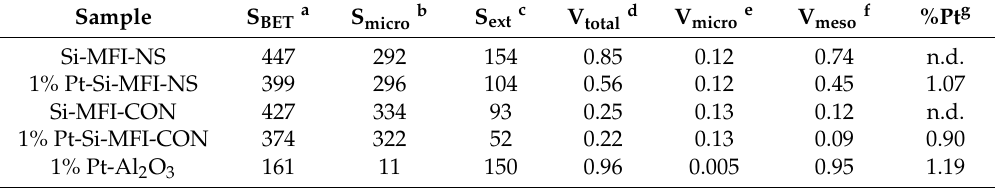
Figure 1. Characterizations of various Pt supported catalysts: ( A ) XRD patterns, ( B - D ) SEM images of Pt supported on hierarchical silicalite- 1 nanosheets (1% Pt-Si-MFI-NS), conventional silicalite- 1 (1% Pt-Si-MFI-CON) and alumina (1% Pt-Al 2 O 3 ), respectively, ( E – G ) TEM images of 1% Pt-Si-MFI-NS, 1% Pt-Si-MFI-CON and 1% Pt-Al 2 O 3 , respectively and ( H ) N 2 sorption isotherms and BJH pore size distributions (see inset). Table 1. Textural properties of Pt supported catalysts, including hierarchical silicalite- 1 .